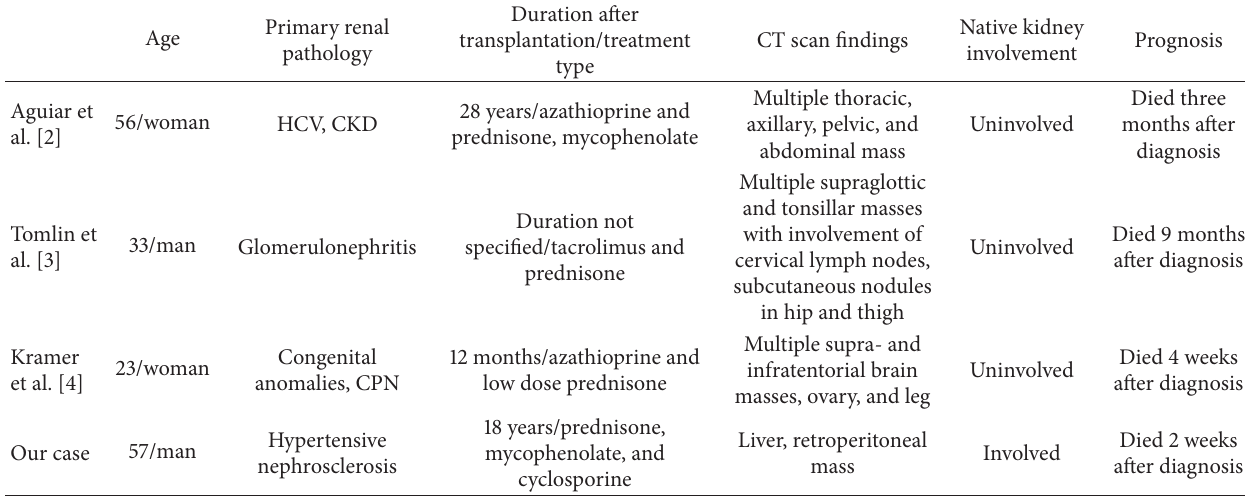
Table 1: Summary of cited cases of HS in renal transplant